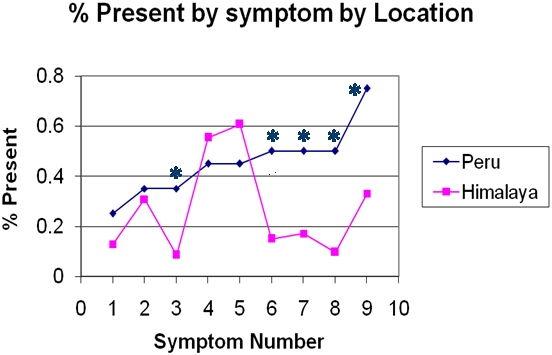
Symptoms (Signs) Number for CMS scores in the Peruvian Andes (4338 m. Peru) and Tibetan plateau (4450 m. Himalaya):1-SaO2_ 2SD below normal for altitude; 2-Breathlesness, palpitations; 3-Sleep disturbances; 4-Cyanosis of lips, face or fingers; 5-dilated veins; 6-Paresthesias in fingers and/or toes; 7-Tinnitus; 8-Hb_2SD above normal for altitude; 9-Headache. *Denotes significant differences. In the Peruvian Andes the % of subjects having: sleep disturbances, paresthesias, tinnitus, high hemoglobin and headache were significantly higher*. Both populations were scored using an internationally accepted scoring system (≥12 = CMS)[11].